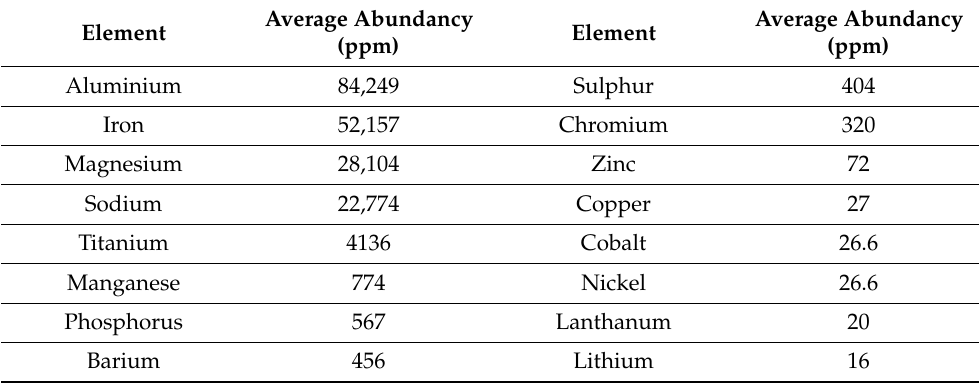
Figure 3. Scheme and working principle of a magnesium rechargeable battery. Adapted with permission from [105]. Copyright John Wiley & Sons, Inc., 2020. Table 2. Average abundancy in the Earth’s crust of the most commonly used elements in the batteries field. Adapted with permission from [106]. Copyright John Wiley & Sons, Inc., 1983.